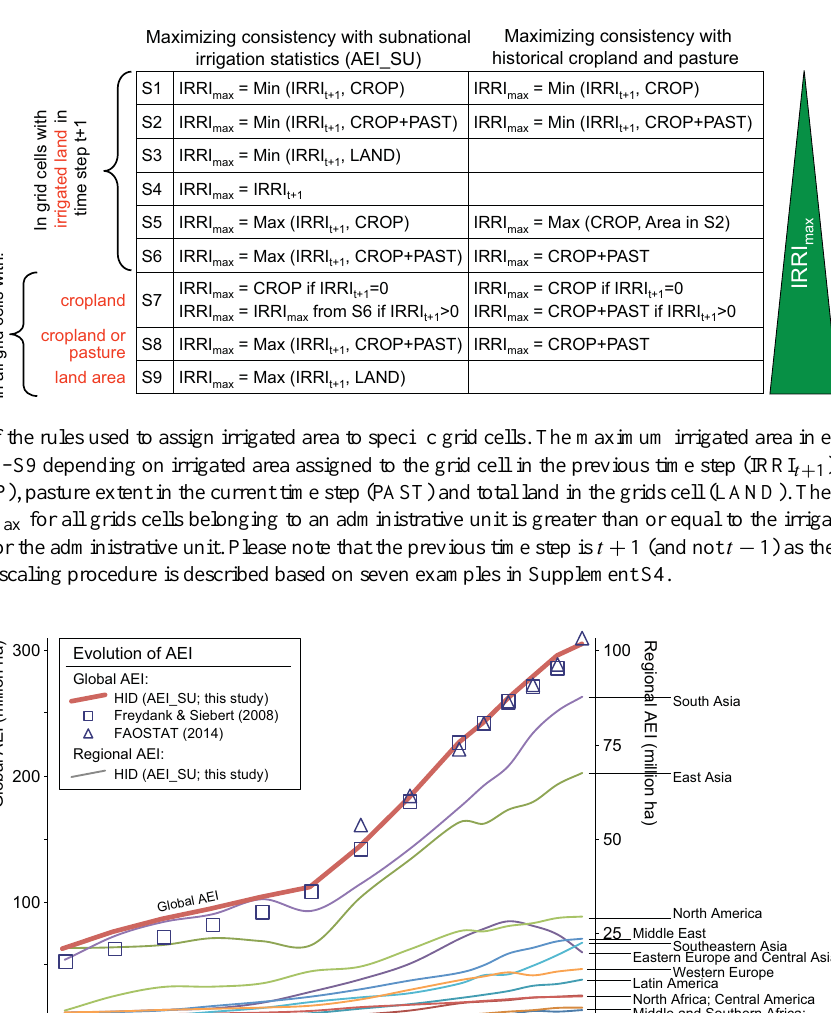
in absolute terms (equal area in each grid cell).